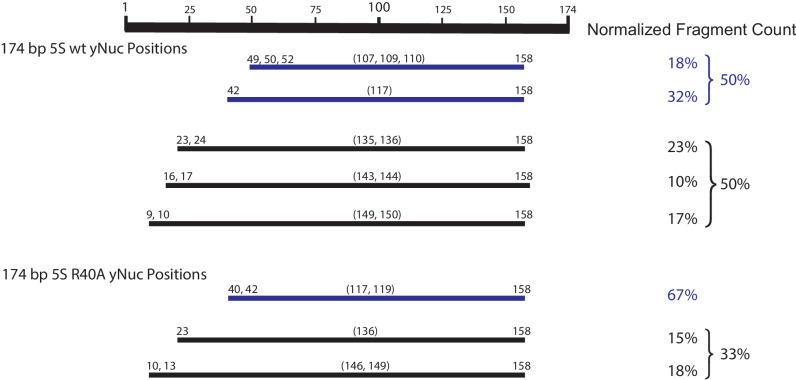
Mapping the positions of the wt and H3 R40A 174 bp sea urchin 5S yeast mononucleosomes.Nucleosome mapping by ExoIII and S1 treatment followed by paired-end next-generation sequencing. Experiment conducted once. Partially wrapped nucleosome fragments (≤120 bp) are depicted in blue. More fully wrapped nucleosome fragments (≥128 bp) are in black.Figure 3—figure supplement 5—source data 1.174 bp 5S nucleosome mapping.